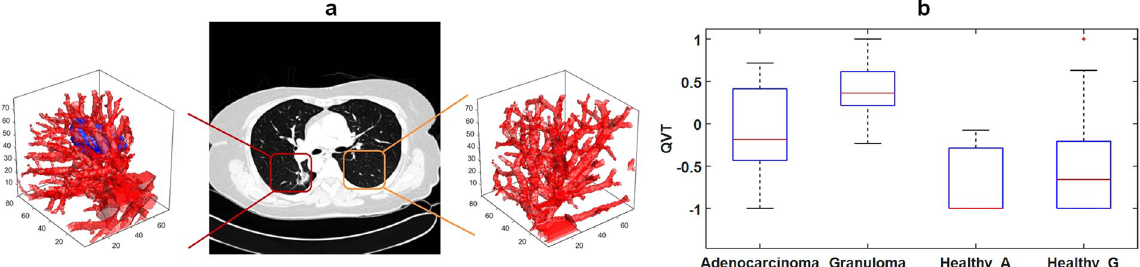
Figure 6. ( a ) 3D renderings of a non-healthy region (left panel including a nodule) and corresponding healthy region (right panel without a nodule). ( b ) The top ranked QVT feature values of the non-healthy regions including adenocarcinomas and granulomas and the healthy regions including Healthy_A and Healthy_G. Healthy_A corresponds to the regions in the opposite lung of adenocarcinomas which had no nodules on them while Healthy_G corresponds to the regions in the opposite lung of granulomas having no nodules on them.